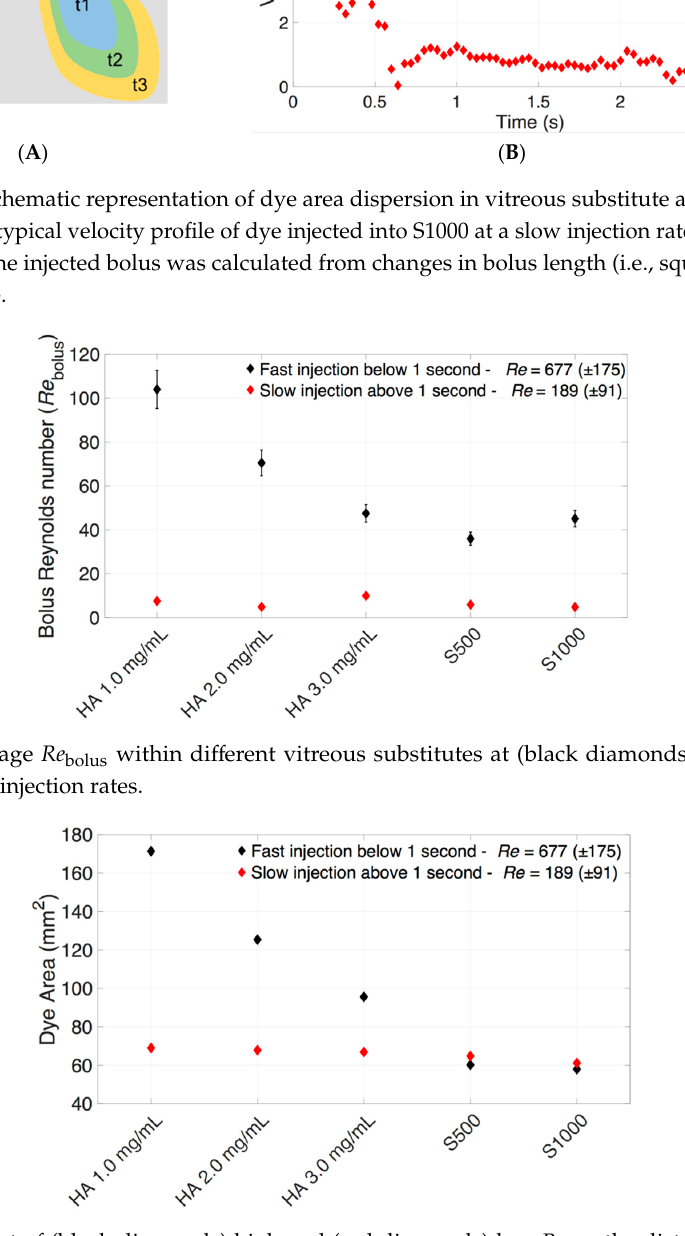
Figure 13. Impact of (black diamonds) high and (red diamonds) low Re on the distribution of dye injected into HA (1.0–3.0 mg/mL) and SO (S500 and S1000). The surface area of the dye was considerably reduced with increasing HA concentrations at fast injection rates compared to slow injection rates. The bolus was more localized in all vitreous substitutes at slow injection